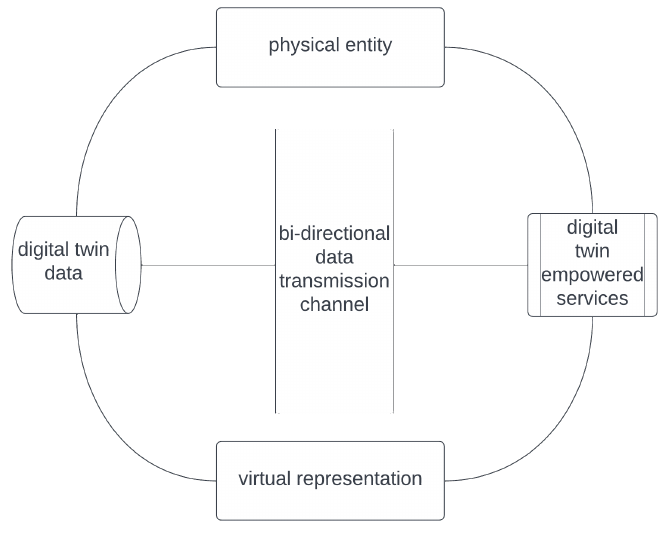
Figure 2. Five-dimensional digital twin